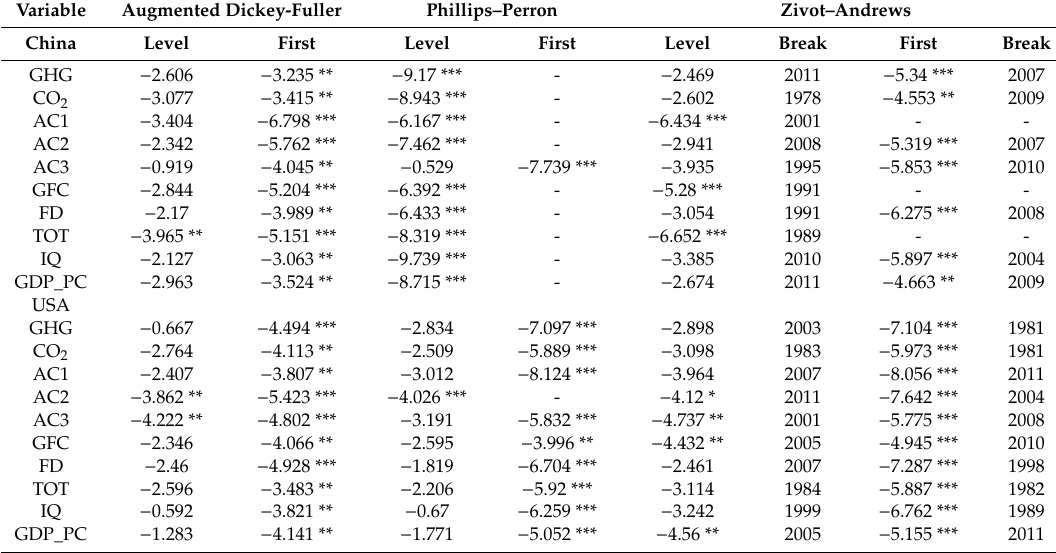
Table 3. Unit-root